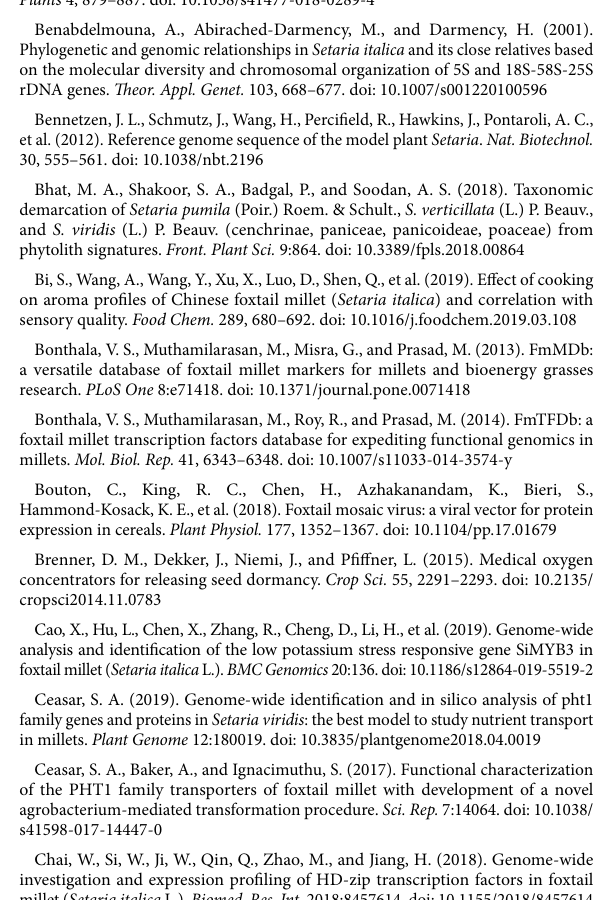
SUPPLEMENTARY FIGURE 1 Physical map showing the candidate genes identified for different traits. The physical map shows the positions of different candidate genes identified in foxtail millet. The highlighted regions in red depict their position on the respective